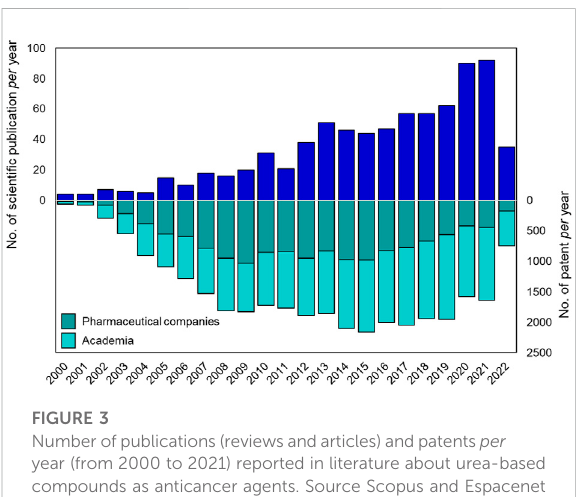
FIGURE 3 Number ofpublications (reviews and articles) andpatents per year (from 2000 to 2021) reported in literature about urea-based compounds as anticancer agents. Source Scopus and Espacenet (last web access on 14 July